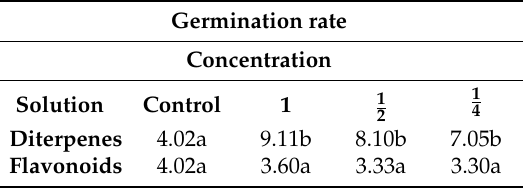
Table 1. Germination rate of the seeds of C. ladanifer watered with solutions of diterpenes and flavonoids at different concentrations (6 replicates per treatment): 1 (0.26 g/L), 1 Different letters indicate significant differences between different concentrations (M-W; p <